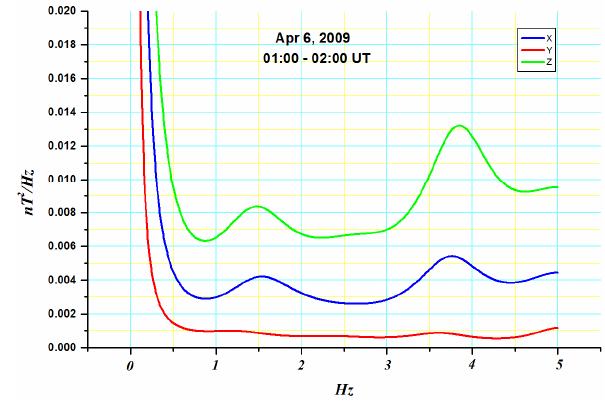
Fig. 11. Power spectrum of the residual field of seimogenic Fig. 11 Power spectrum of the residual field. Signals were selected before and after the co- seismic signals in order to isolate the signals of possible tectonic origin from the signals produced by ground motion.